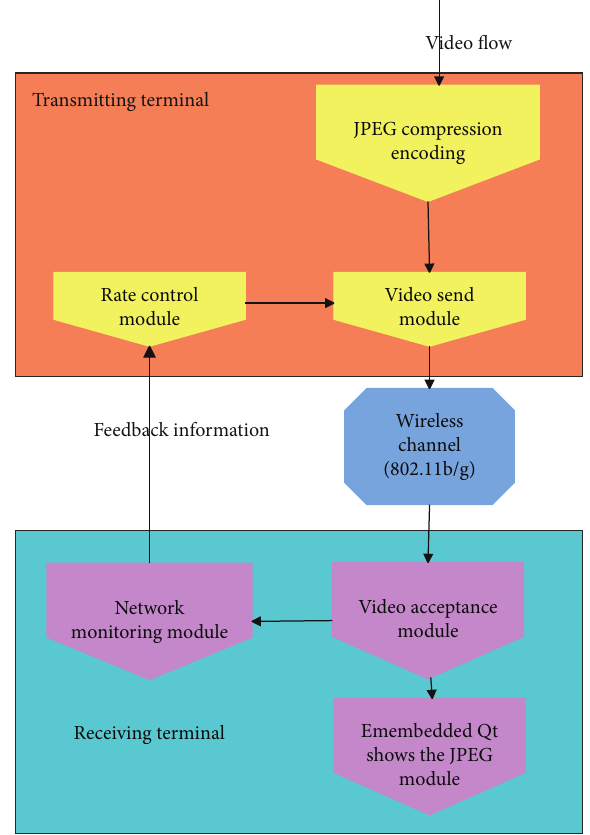
Figure 11: Video transmission system.